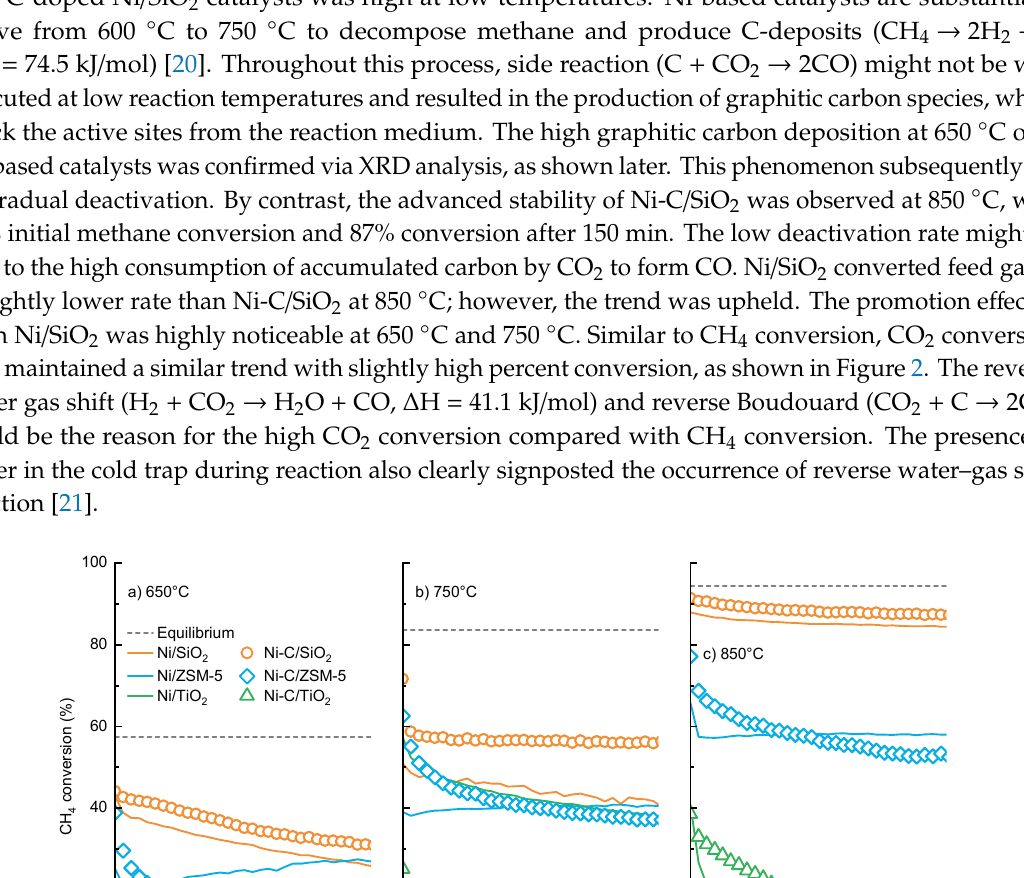
Figure 2. CO 2 conversion in DRM with prepared catalysts at different temperatures. ( a ) 650 °C, ( b ) 750 ◦ C, ( c ) 850 ◦